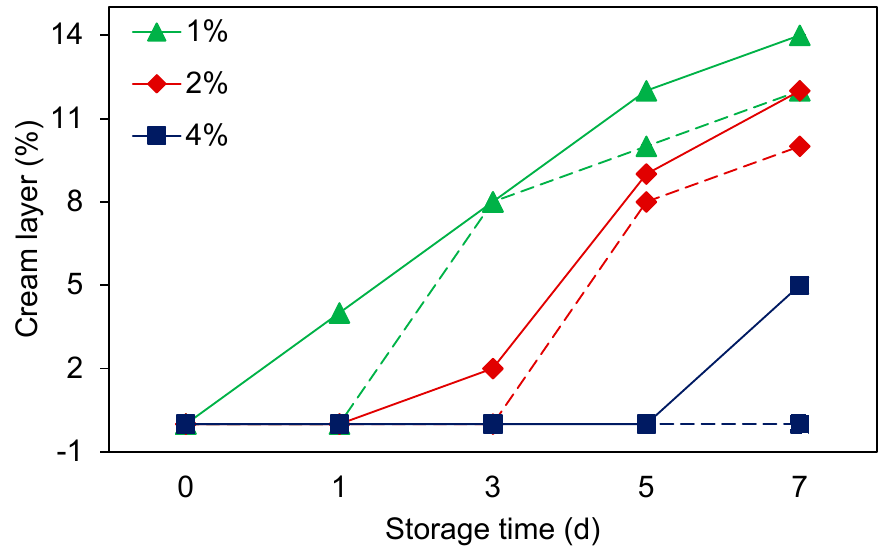
Figure 5. Influence of peptide fractionation on creaming stability in nanoemulsions during 7 d at 25 ◦ C. Emulsifiers: UC–10F chymotrypsin WPI fraction (broken lines) and unfractionated chymotrypsin WPI hydrolysate (solid lines) at varying concentrations (1–4%). Data for unfractionated chymotrypsin WPI hydrolysate were from Adjonu et al.